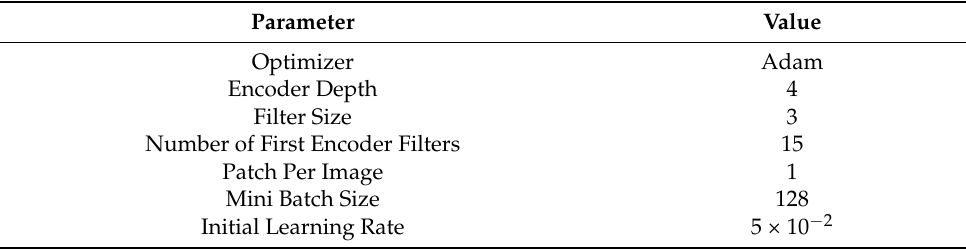
Figure 4. ( a ) thresholding applied in MRI, ( b ) region growing, ( c ) 3D mesh model (STL model), and ( d ) STL model converted into matrix. Table 1. Skull Segmentation Implementation